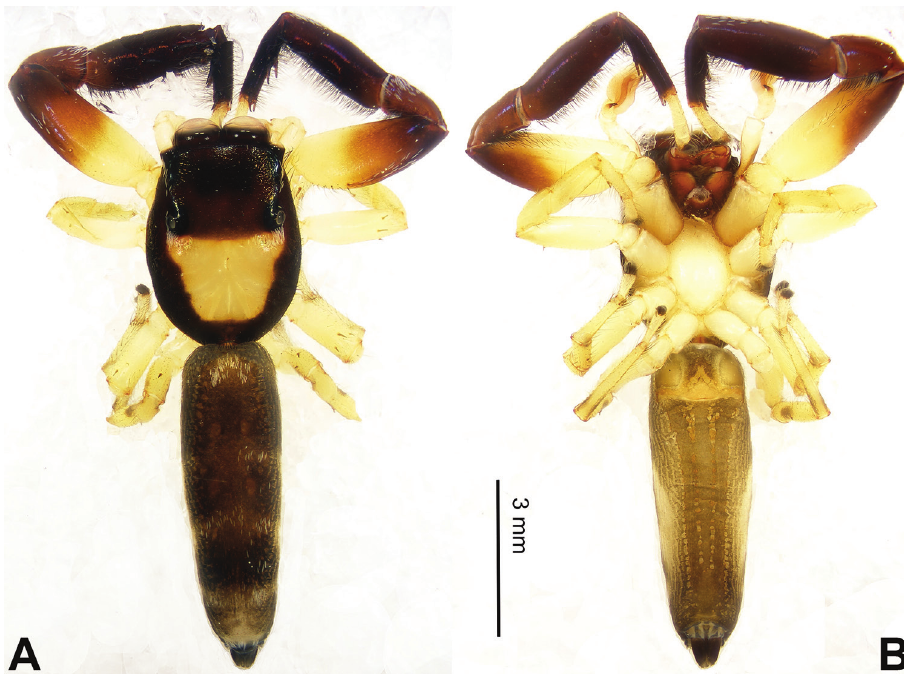
Figure 8. Habitus of Bavia exilis sp. n., male holotype. A dorsal B ventral. lowish. Abdomen elongate, slender and grey. Venter and spinnerets dark greyish. Legs I more robust and darker than others, legs II–IV yellowish. Spination of leg I: femur d1-0-0; tibia v2-2-2; metatarsus v2-0-2. Palp: tibia short, about 1/4 length of cym- bium. Tibial apophysis bent, subequal to the length of tibia (Fig. 7B). Embolus short and pointed, with retrolateral membranous margin (Fig. 7C). Female.